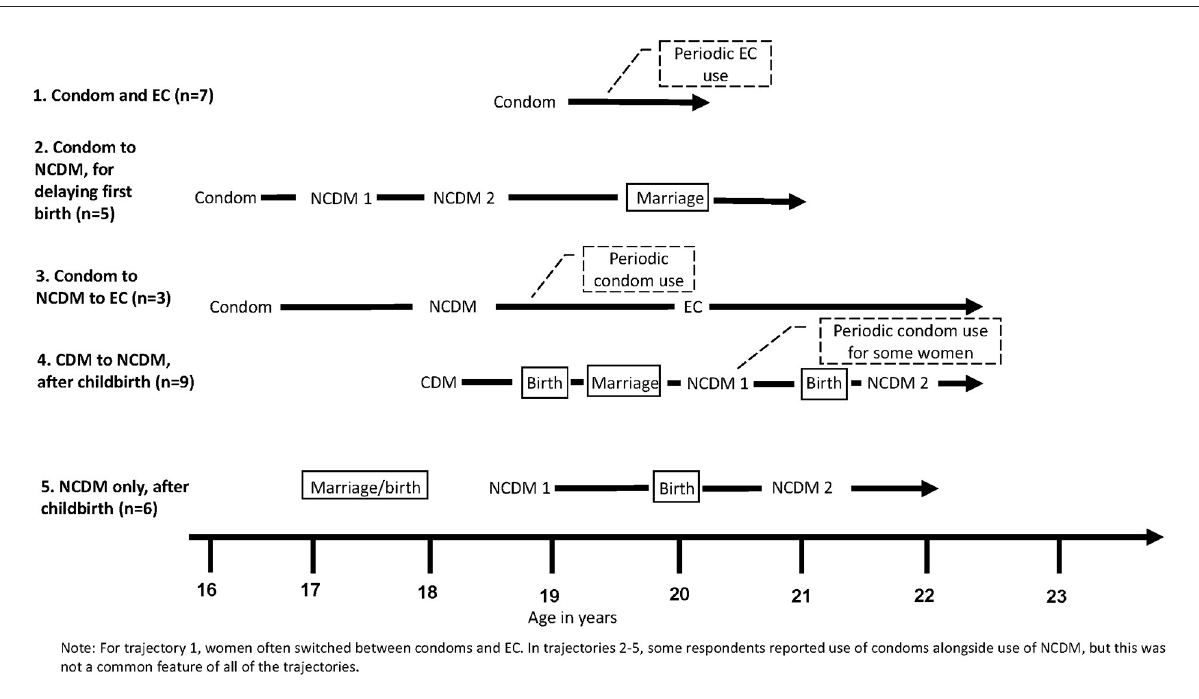
FIGURE1 Five trajectories to contraceptive use and method choice.